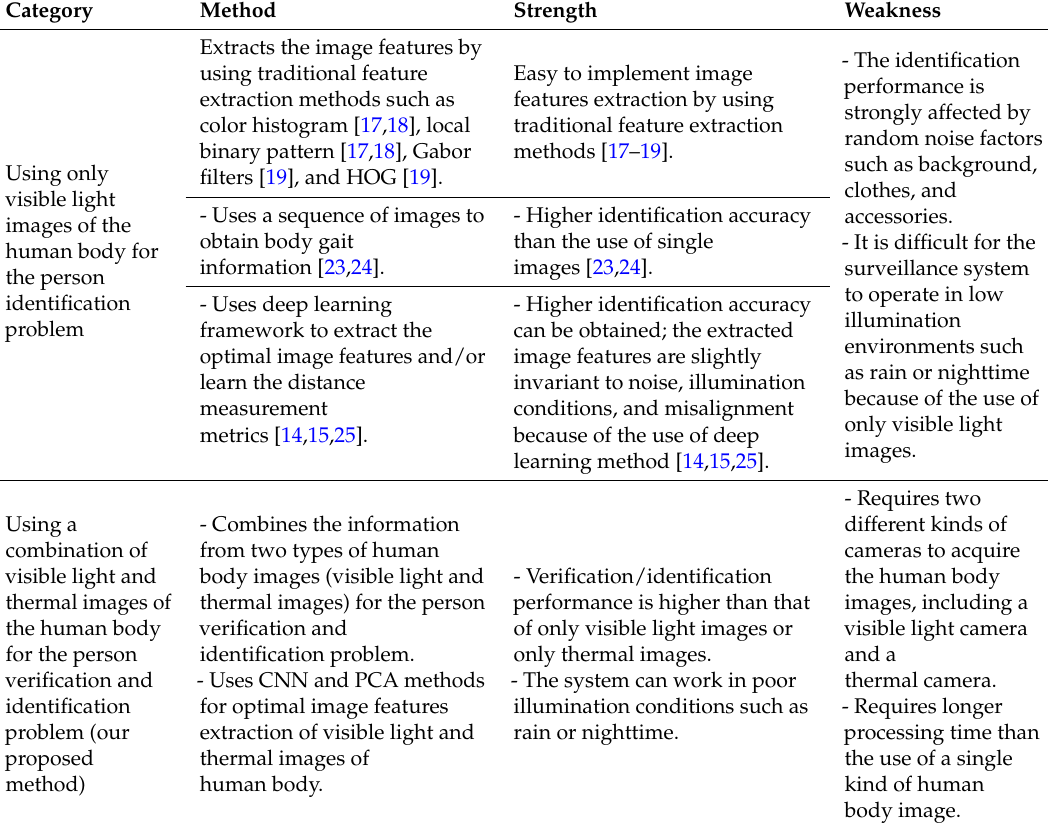
Table 1. Summary of previous and proposed studies on person recognition (verification/identification) using body